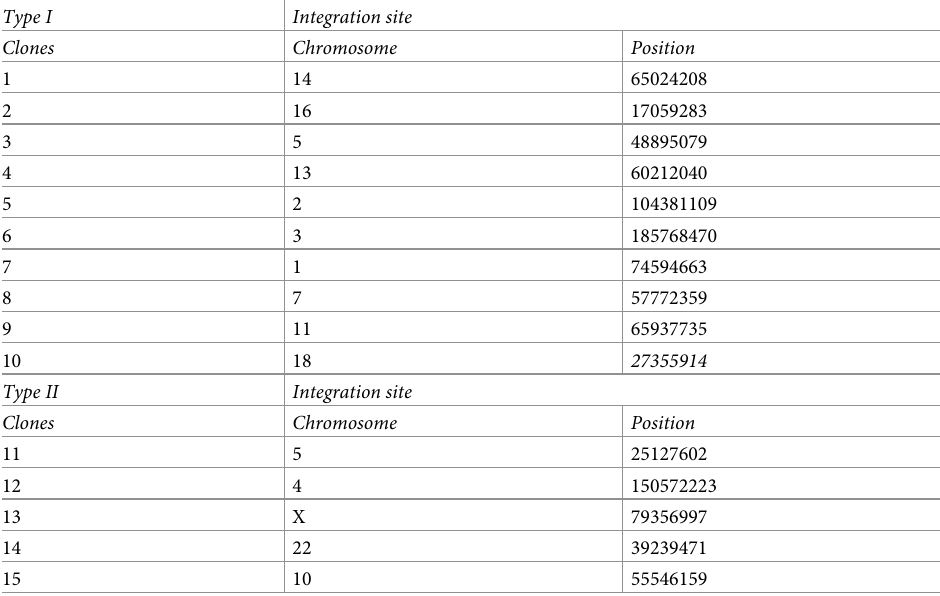
Table 2. HTLV-1 infected Jet cell clones. Positions of HTLV-1 integration sites are shown for each cell